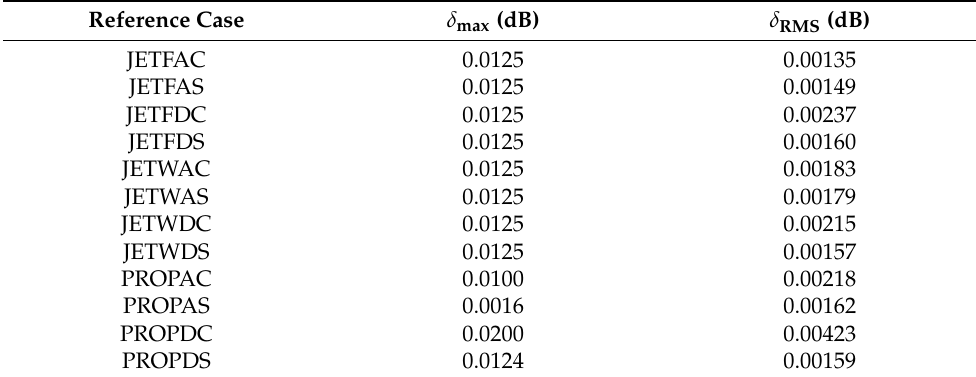
Table 1. Errors between the calculated noise levels and the reference results.